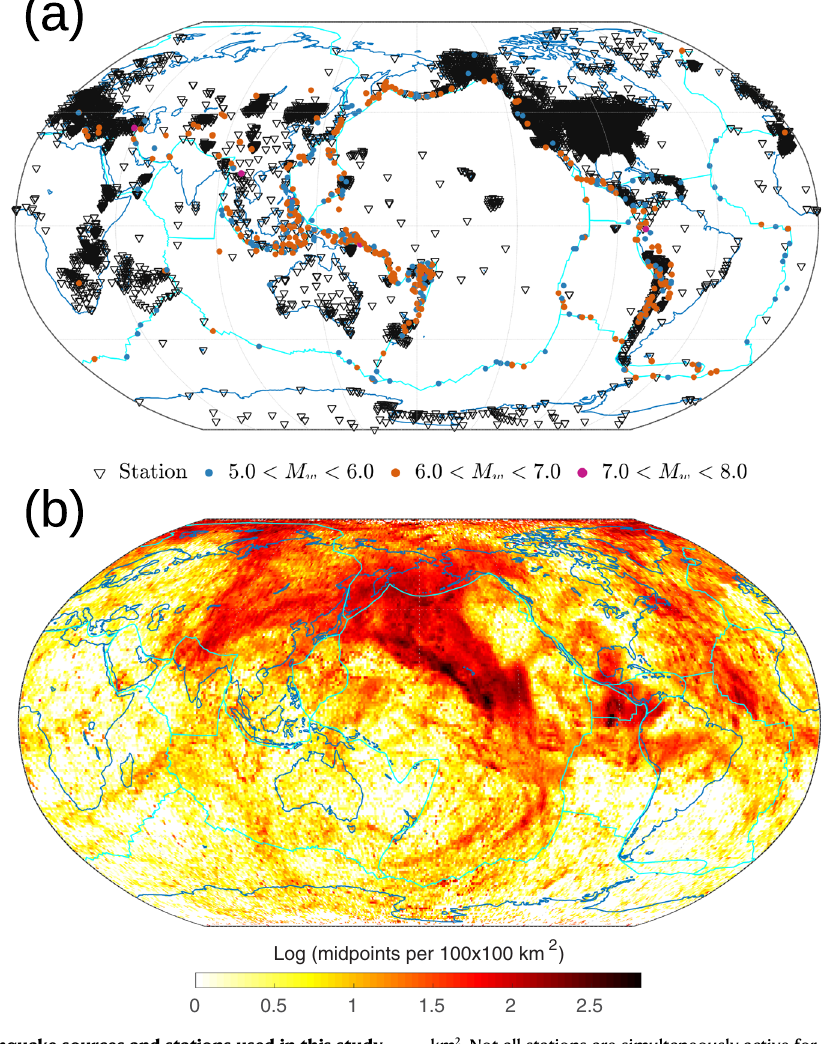
km 2 . Not all stations are simultaneously active for all earthquakes. The coverage, while global, is densest in the central Paci fi c area of interest. Note that we do not display the PS and SP bounce points, which provide additional illumination. In our images, the dominant contribution is from SS